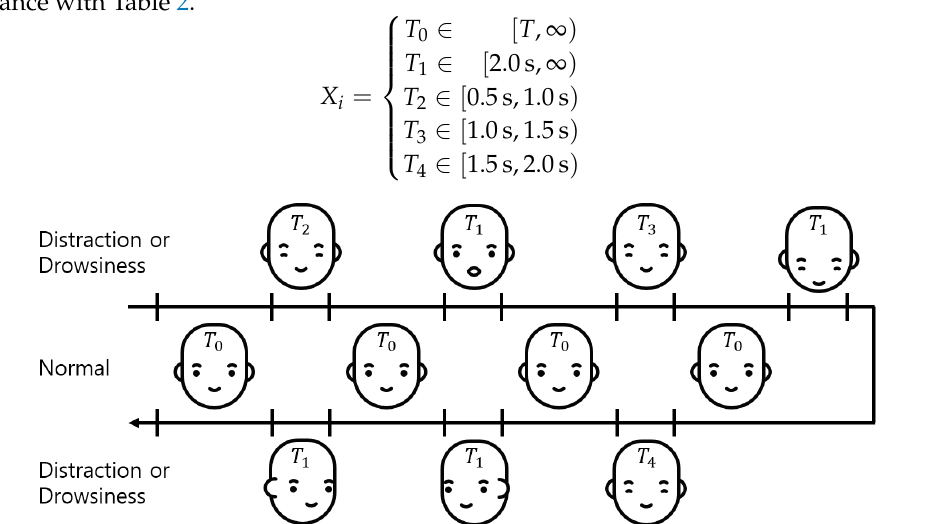
Figure 5. Acquisition procedure of the time-series